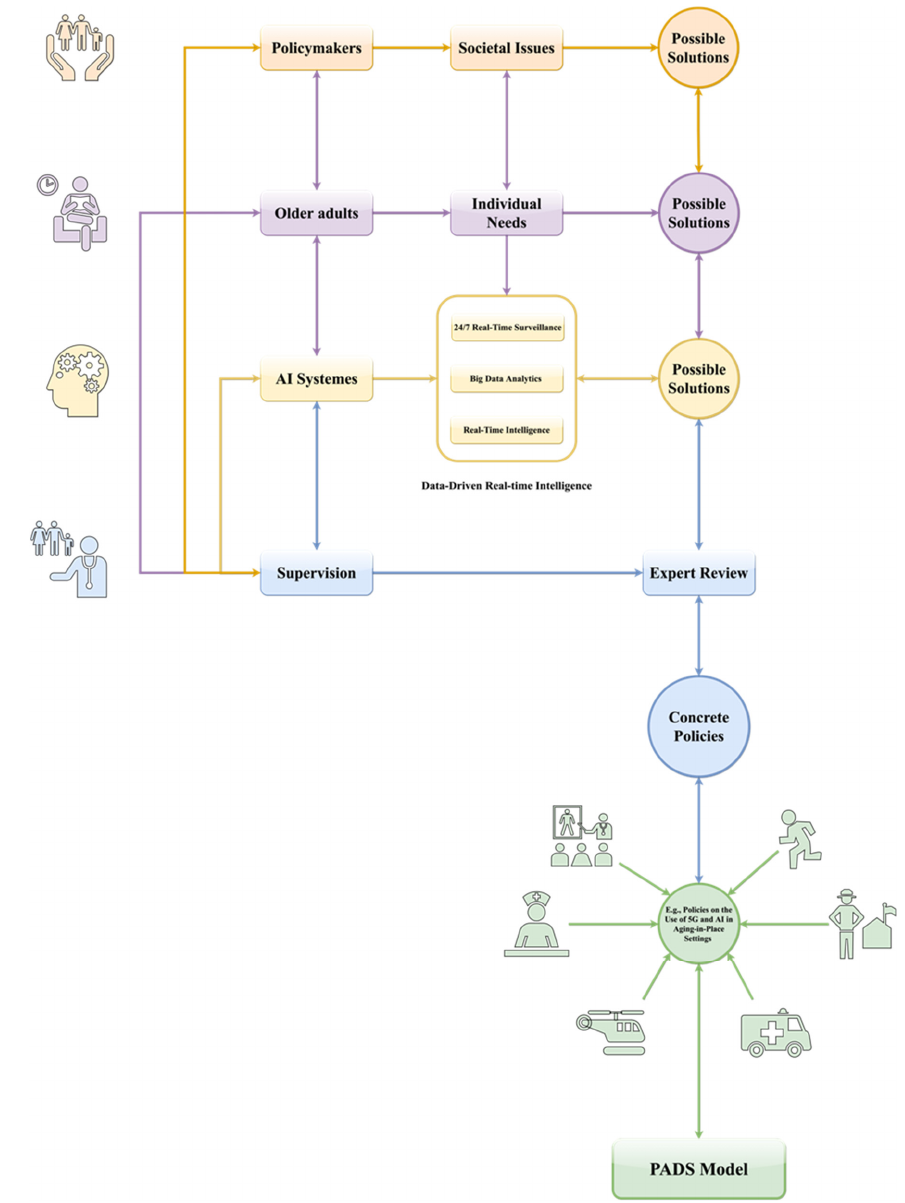
Figure 2. An example utilization of the PADS model in the context of aging-in-place policies.